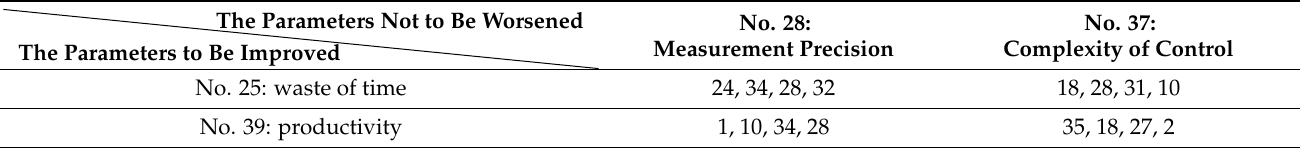
Table 1. Technical contradiction matrix